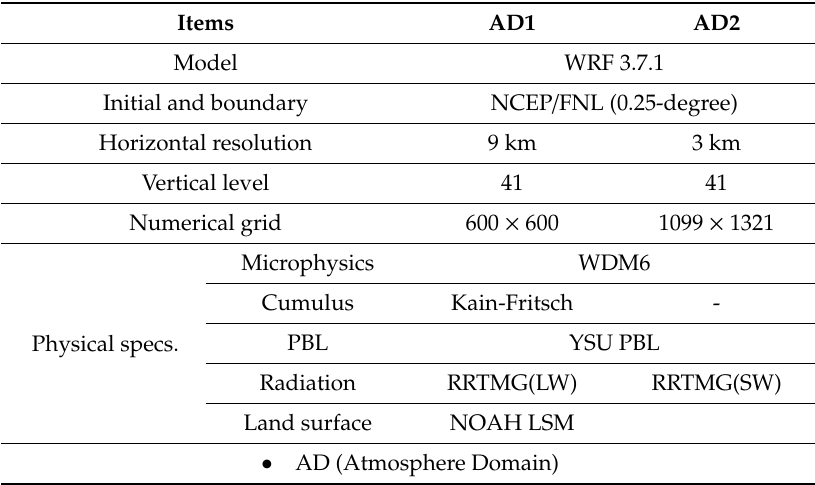
Figure 2. Model description for simulation of typhoon-induced coastal inundation (AD: Atmosphere Domain, OD: Ocean Domain). Table 1. Model description of the